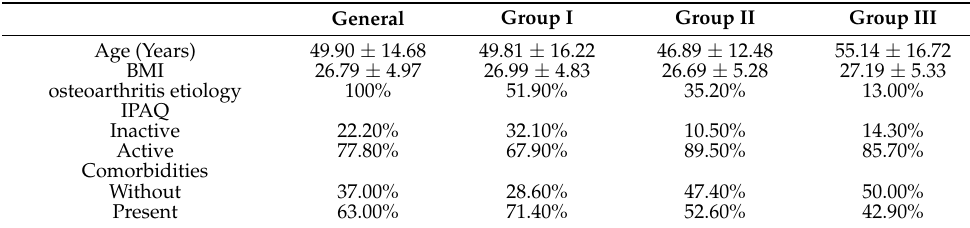
Table 1. Characterization of the 54 subjects.